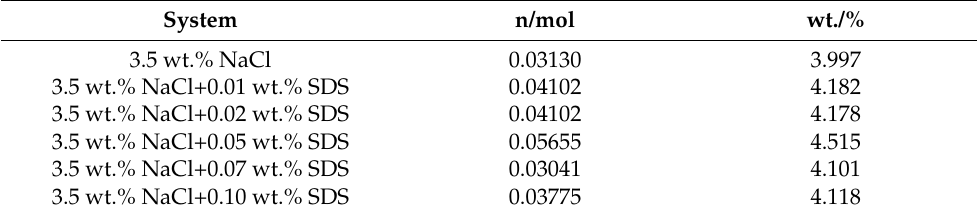
Table 2. Gas consumption and NaCl concentration after hydrate formation.